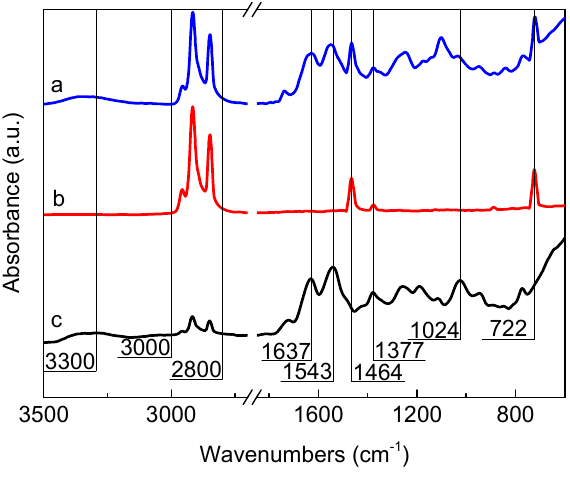
Figure 3. FTIR spectra of paraffin/PUF microcapsules ( a ), raw paraffin ( b ), and PUF ( c ).